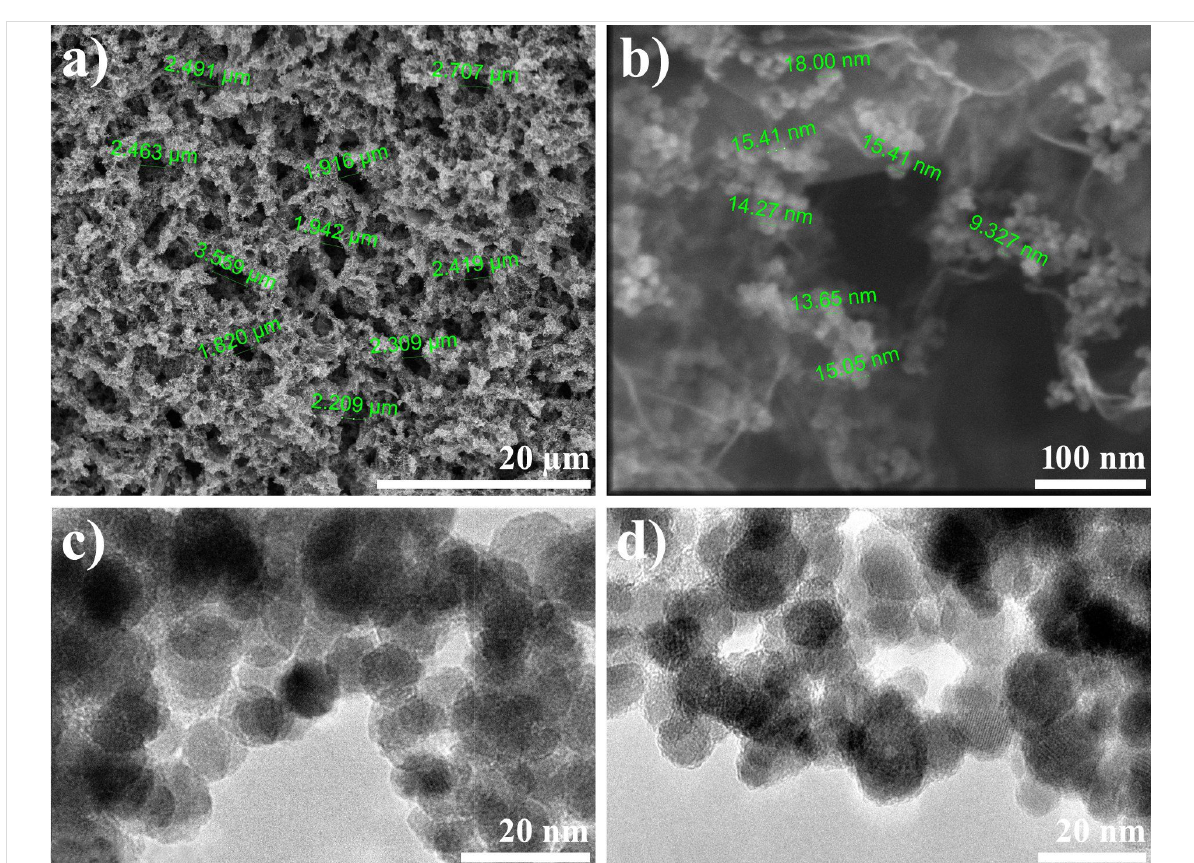
Figure 2: SEM micrographs of rGO-PDA@Fe 3 O 4 aerogel (a,b) and TEM micrographs of Fe 3 O 4 (c) and PDA@Fe 3 O 4 nanoparticles